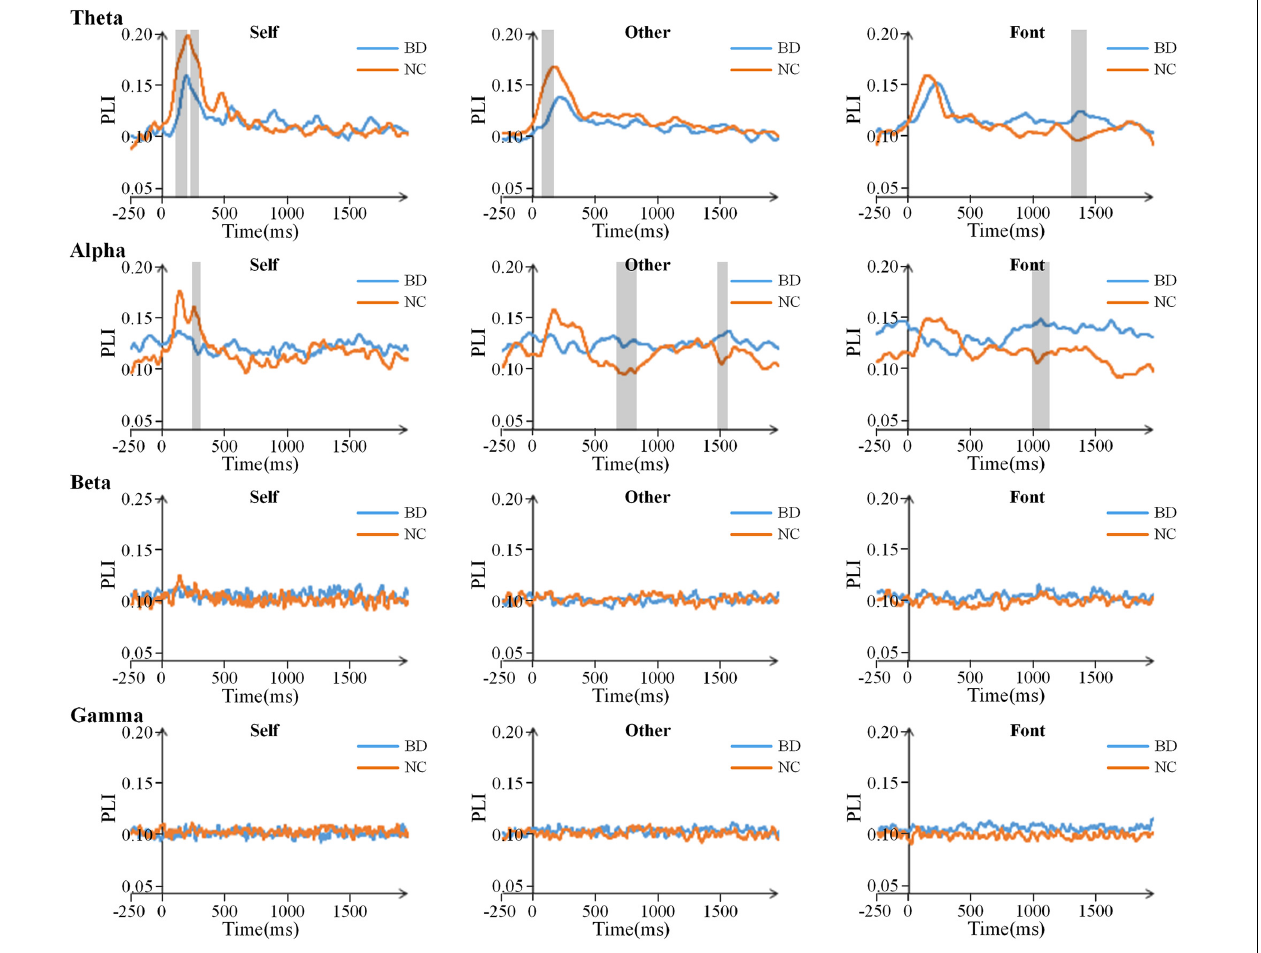
FIGURE 4 | Time courses of the average PLI values for BD and NC in the four bands. The gray areas are the time windows in which there was a significant difference between BD and NC. BD, bipolar disorder; NC, normal control; PLI, phase lag index.